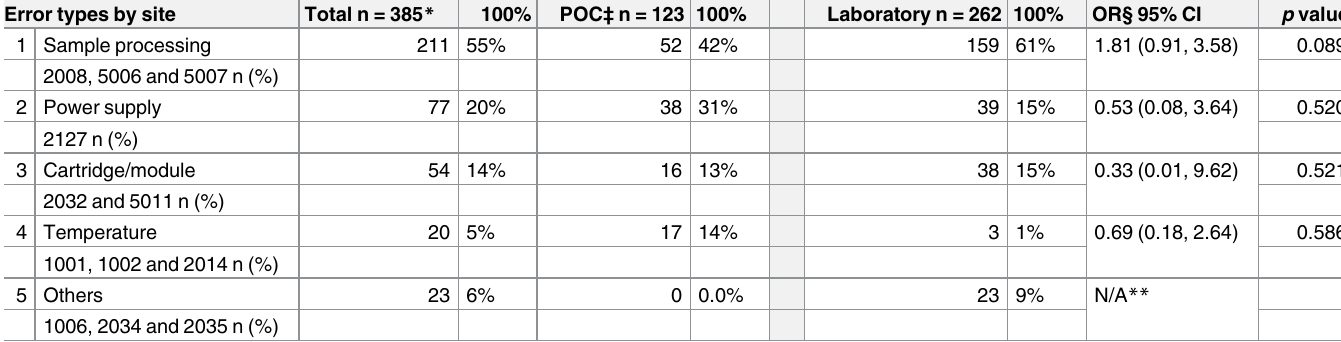
Table 3. Type of Xpert error by GeneXpert site in Botswana, October 2012 to